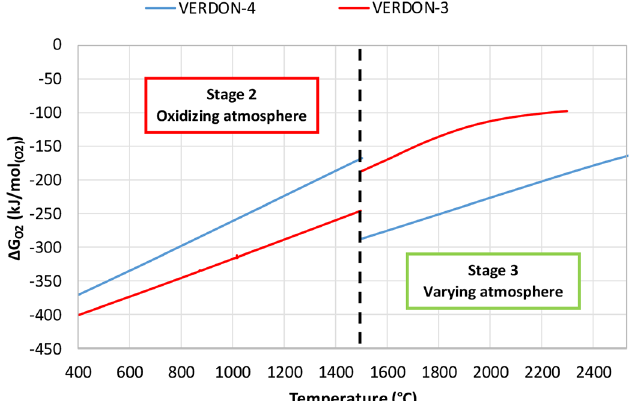
Fig. 2. Evolution of the oxygen potential during the stage 2 and 3 of the VERDON-3 and 4 tests, calculated from the H 2 O/H 2 system using Thermo-Calc [1] coupled with the TAF-ID [2].